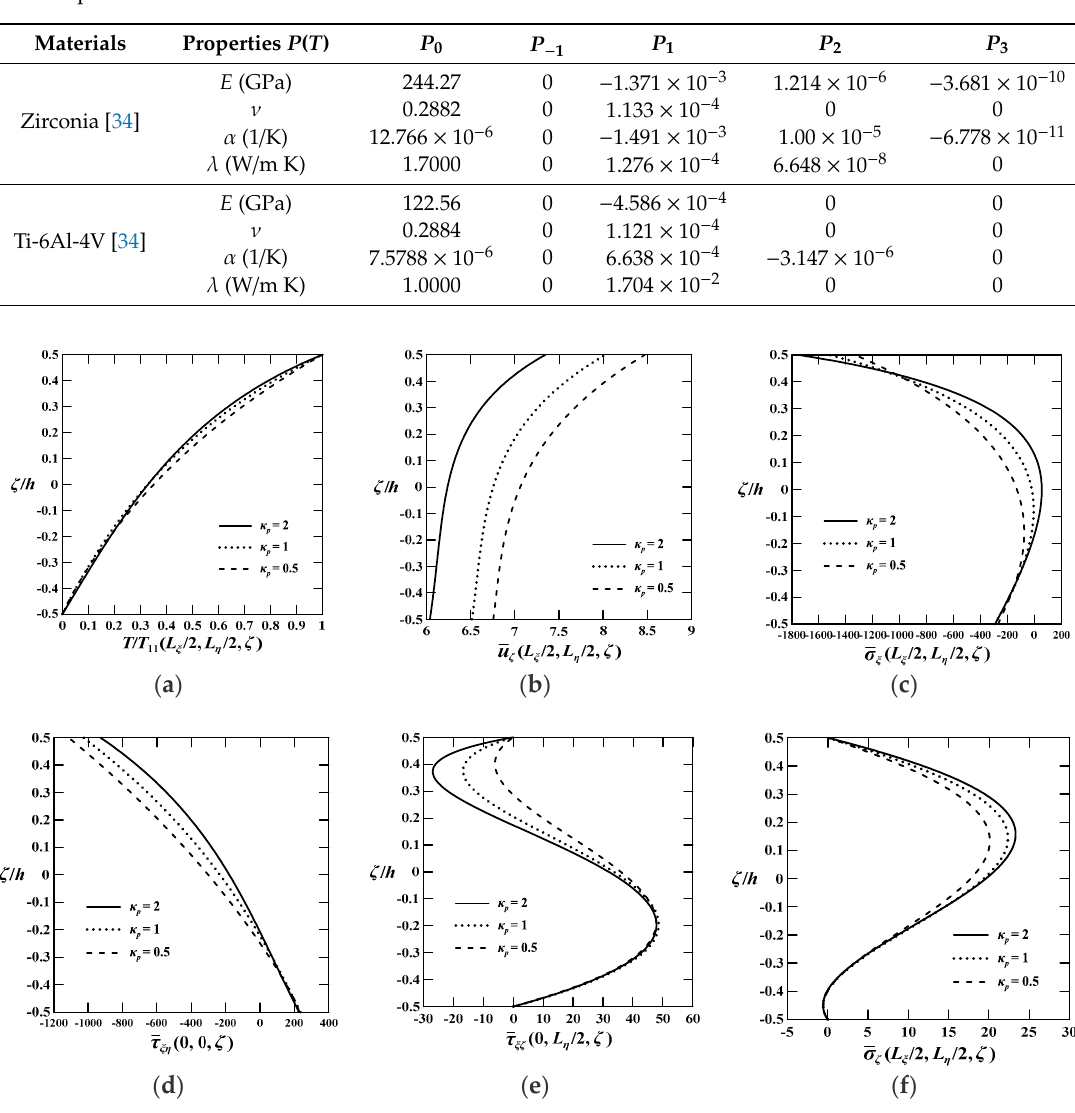
Table 3. Temperature-dependent material properties of metal and ceramic materials (Ti-6Al-4V and zirconia), in which P = P 0 temperature and its unit is K.